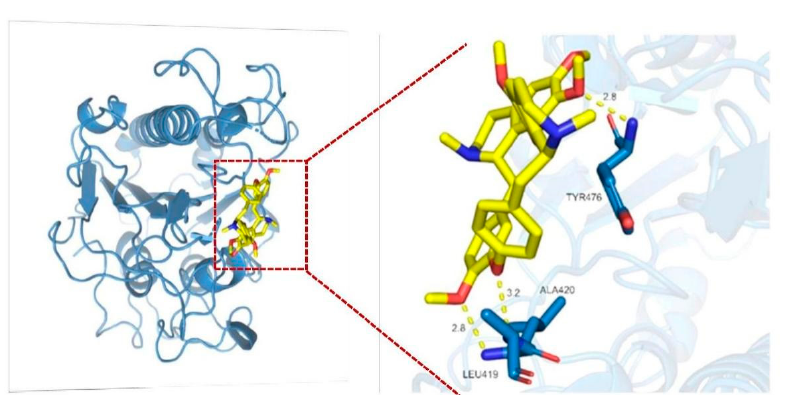
Figure 6. Molecular docking of tetrandrine and MCR-1 protein show that tetrandrine forms hydrogen bonding with three amino acids of MCR-1 protein in its active sites, suggestive of inhibition of MCR-1 in terms of colistin